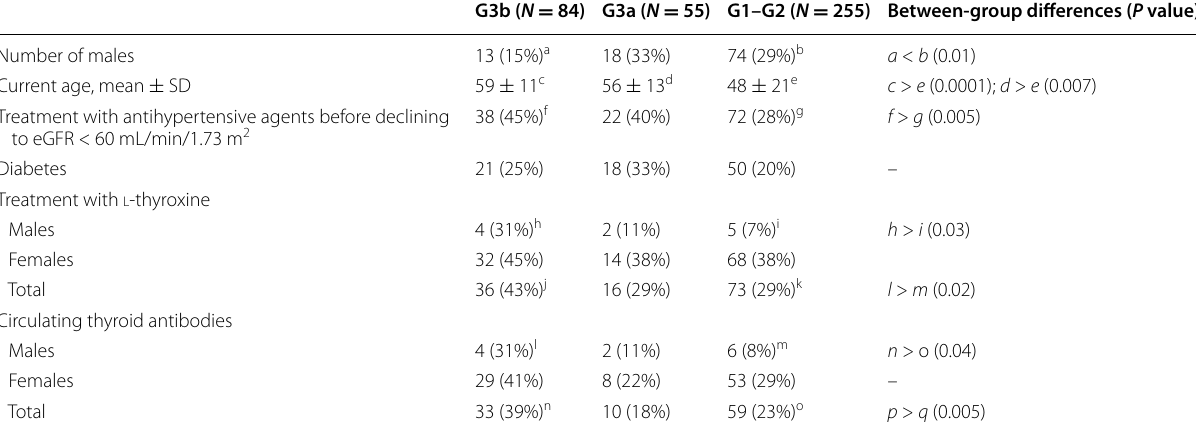
Superscripts a–o are used to indicate significant between-group differences